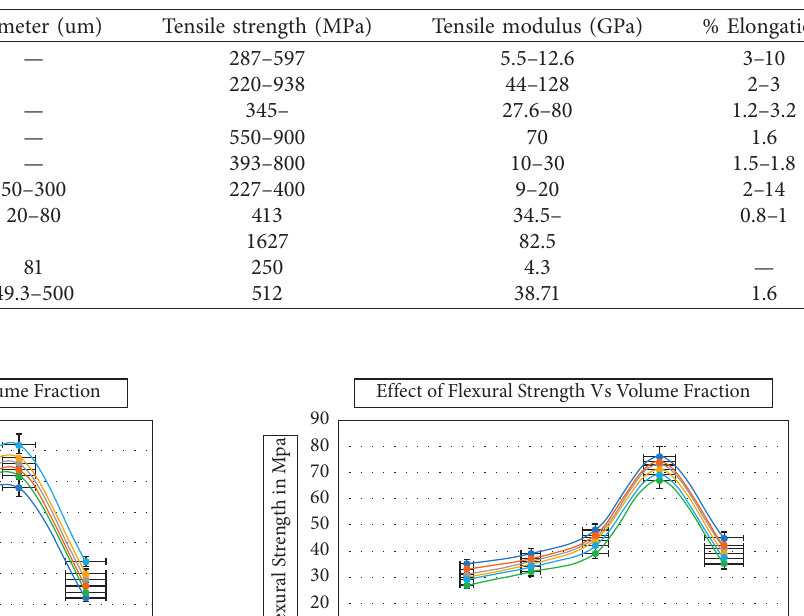
Table 2: Difference between the tensile behavior of AAM fiber with numerous natural fibers.